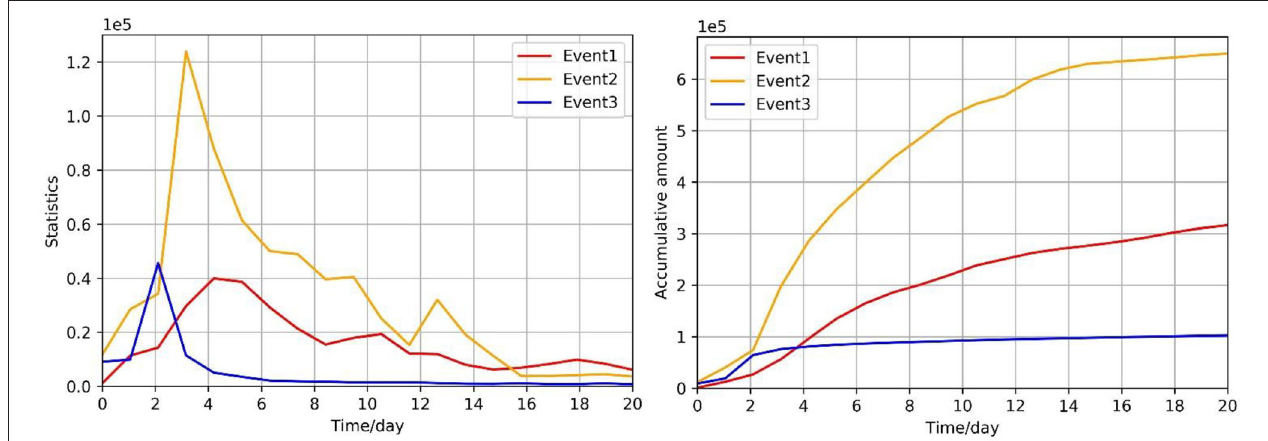
FIGURE 1 | The amount of information on three network public opinion